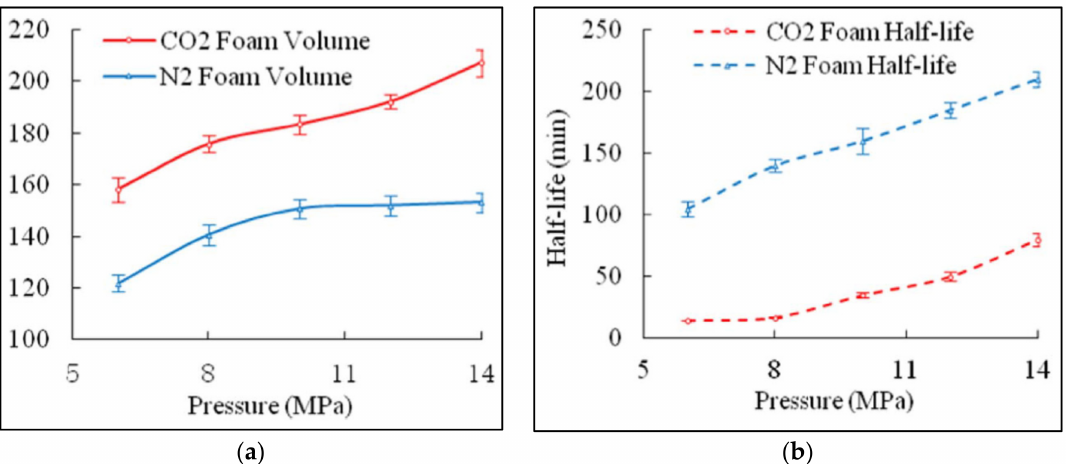
Figure 19. Pressure effect on ( a ) foam volume and ( b ) half-life of foam ( Reprinted with permission from Wang et al. [61]). Copyright 2017, Elsevier